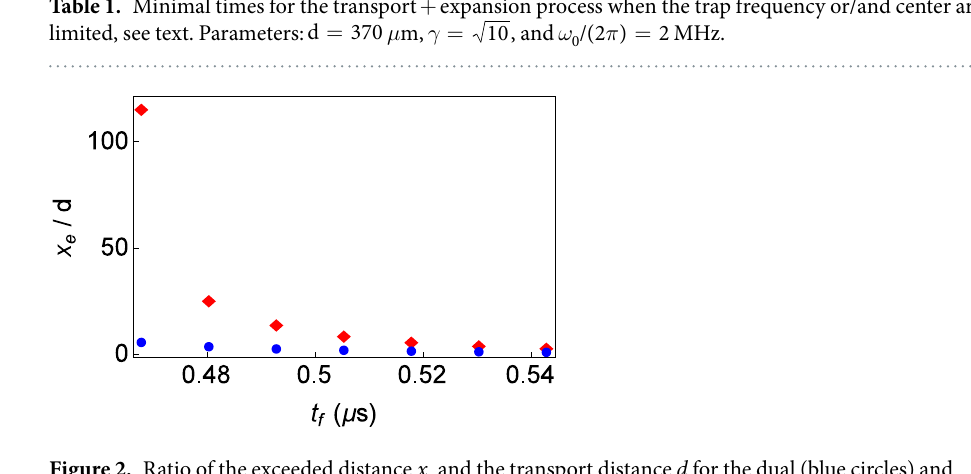
Figure 2. Ratio of the exceeded distance x e and the transport distance d for the dual (blue circles) and sequential (red diamonds) non-rigid harmonic tranport protocols, for final times that do not require imaginary frequencies. Parameters used are =